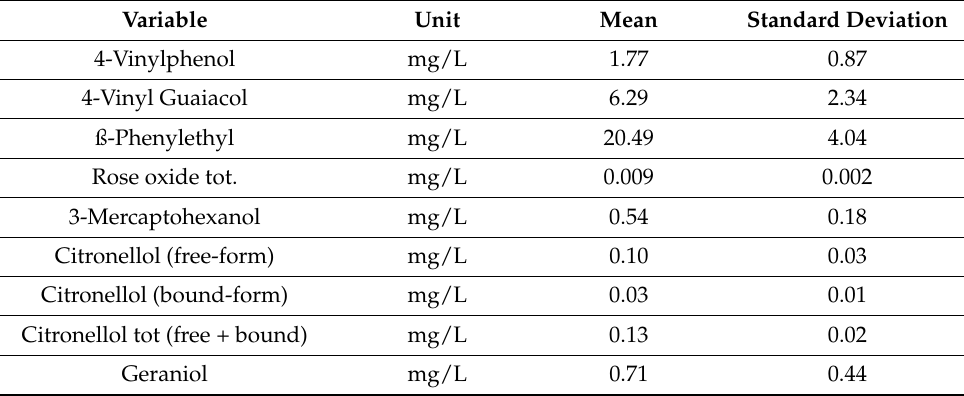
Table 8. Means and standard deviations of mineral elements in wine (see Table S4 in the Supplementary